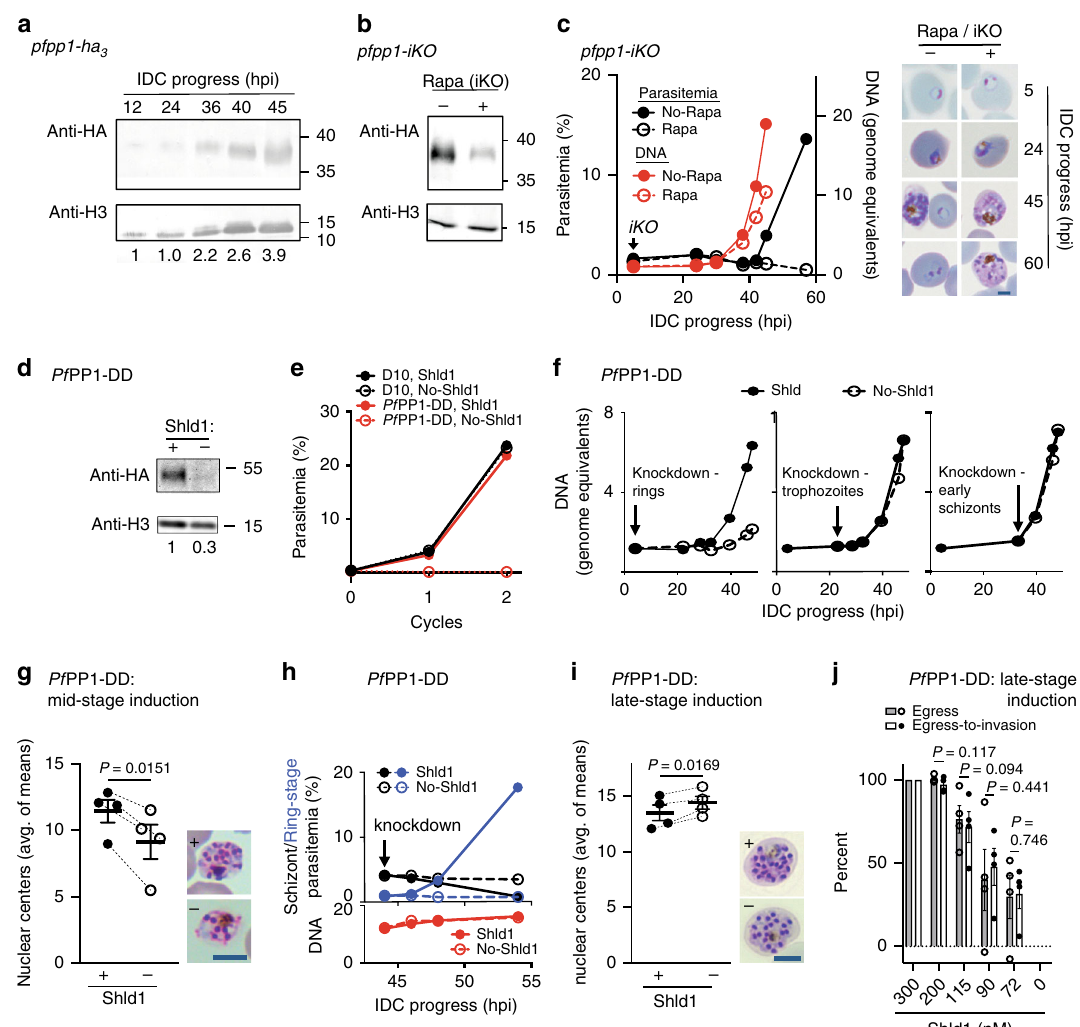
Fig. 1 Isolating an essential P f PP1 function late in the intraerythrocytic developmental cycle. a Pf PP1-HA 3 expression during intraerythrocytic development (hours post-invasion, hpi), assessed by immunoblot. Relative Pf PP1 levels (below lanes) are normalized to histone H3. Representative of 3 experiments. Molecular mass in kDa. b iKO of pfpp1 was initiated at 5 hpi with rapamycin (Rapa) and protein levels were assessed by immunoblot at 30 hpi (sample processing control on separate gel). Representative of 2 experiments. Molecular mass in kDa. c Left: Parasitemia and DNA synthesis over the IDC following + / − Rapa-treatment at 5 hpi in pfpp1-iKO parasites, monitored by fl ow-cytometry. Mean of 3 technical replicates. Representative of 4 experiments. Right: Images of parasites along the IDC, following + / − Rapa-treatment at 5-hpi. Scale bar: 2 µ m. d HA-tagged Pf PP1-DD protein from schizont-stage parasites (~48 hpi) grown + / − Shld1 for 6 h, assessed by immunoblot. Molecular mass in kDa. Representative of 1 experiment. e Proliferation of Pf PP1-DD and parental D10 parasites (wild type), + / − Shld1, monitored by fl ow-cytometry. Knockdown was induced in cycle-zero. Mean of 2 technical replicates. Representative of 2 experiments. f DNA replication in Pf PP1-DD parasites following knockdown at the indicated timepoints, monitored by fl ow-cytometry. Mean of 2 technical replicates. Representative of 4 experiments for ring-stage induction, 2 experiments for trophozoite- stage induction, and 2 experiments for early schizont-stage induction. g Left: Nuclear centers in terminally developed Pf PP1-DD parasites, assessed by light microscopy. Knockdown induced at 22-30 hpi. Mean± s.e.m.; n = 4 experiments; two-tailed t test. Right: Representative images of terminal parasites + / − Shld1. Scale bar: 5 µ m. h Top: Schizont and ring-stage parasites monitored by fl ow-cytometry following induction of Pf PP1-DD knockdown ( + / − Shld1) late in the IDC. Bottom: DNA content in the parallel samples, with addition of E64 (50 µ M). Mean of 2 technical replicates. Representative of 2 experiments. i Nuclear centers following Pf PP1-DD knockdown at 44 hpi, as in g . Mean ± s.e.m.; n = 4 experiments; two-tailed t test. Scale bar: 5 µ m. j Egress and egress-to-invasion following induction of partial Pf PP1-DD knockdown at sublethal doses of Shld1. Mean± s.e.m.; n = 4 experiments; two-tailed t test. Source data are provided as a Source Data fi